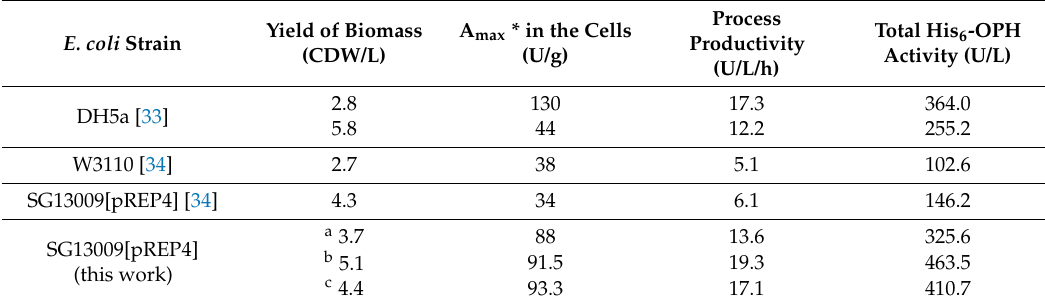
Table 4. Basic characteristics of various techniques for producing His 6